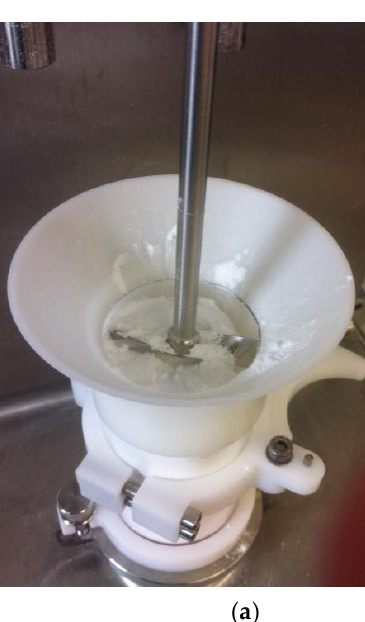
Figure 3. Experimental configurations for ( a ) preconditioning a powder and ( b ) compaction using the FT4 [9,10].